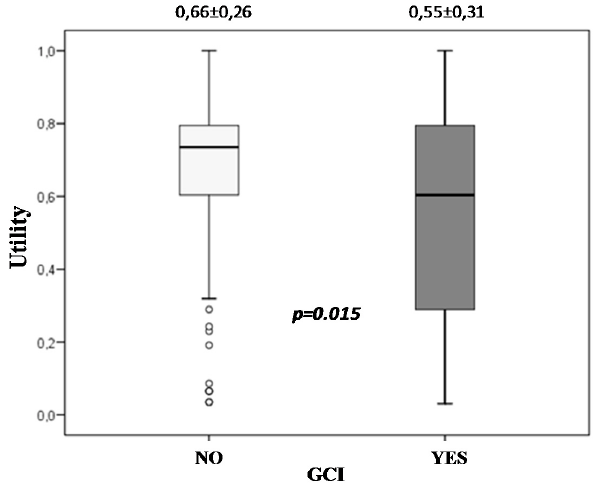
Figure 4. Global cognitive impairment and quality of life. Patients with GCI had a poorer quality of life at 2 years post ischemic stroke.